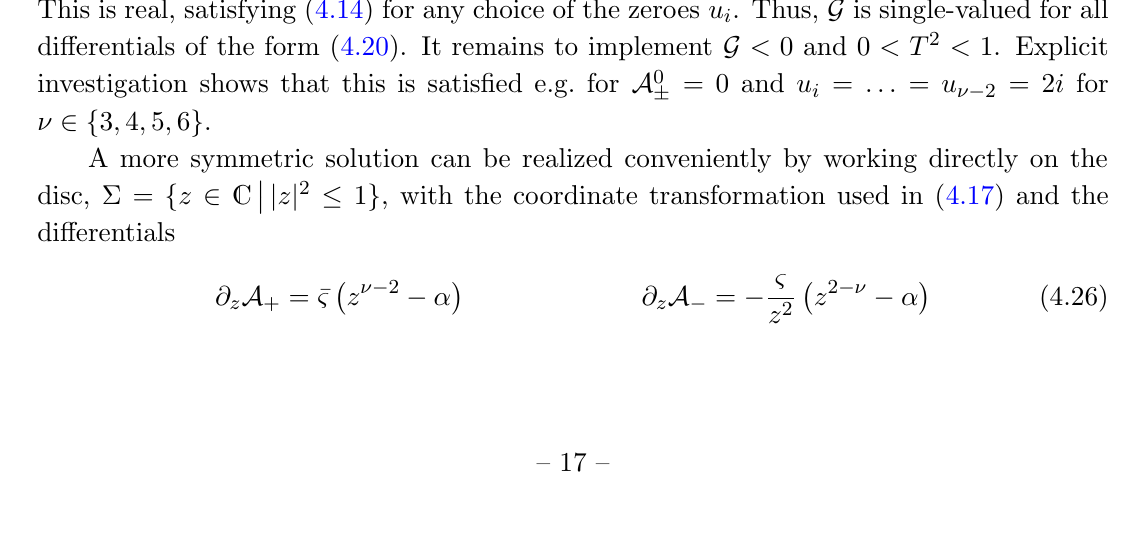
= i in (4.17). Because the metric factors + 2 2